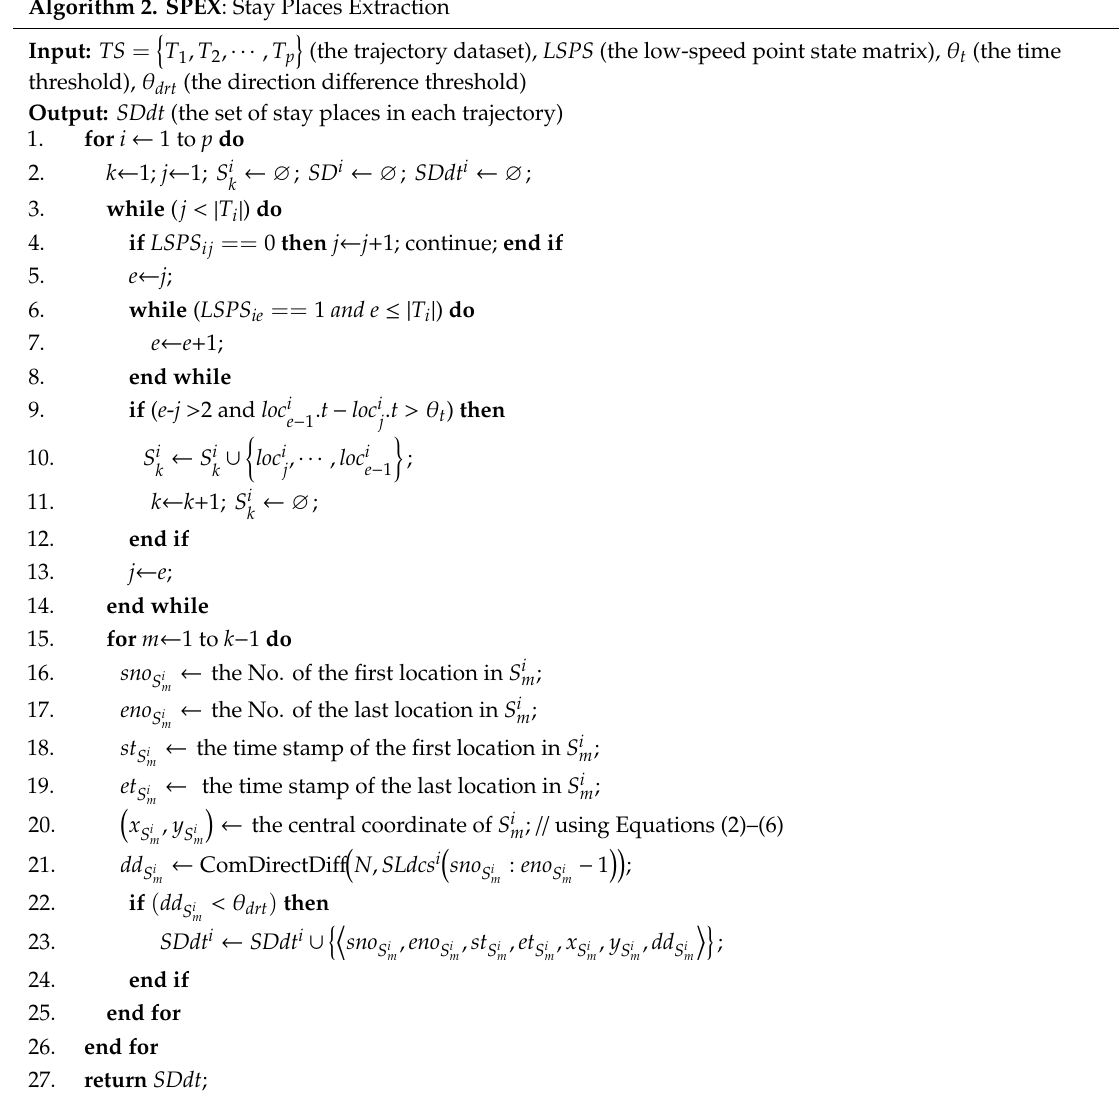
Algorithm 2. SPEX : Stay Places